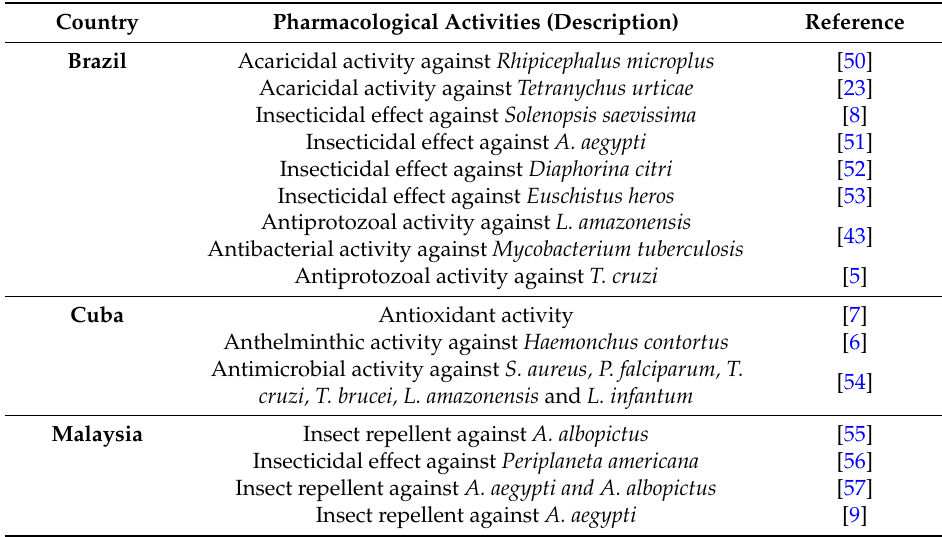
Table 4. Pharmacological reports of essential oil from Piper aduncum L. according to geographical location.